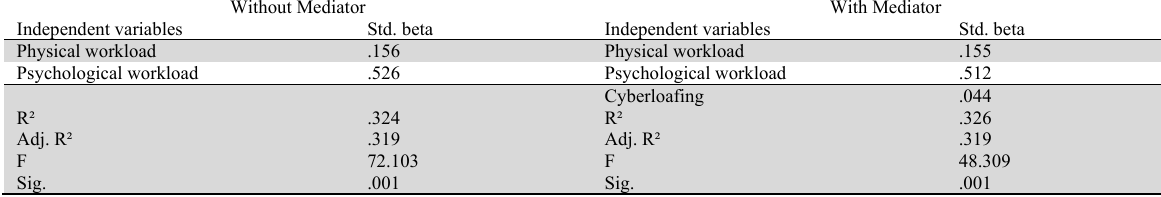
The Mediating Effect of Cyberloafing between Workload Dimensions and organizational